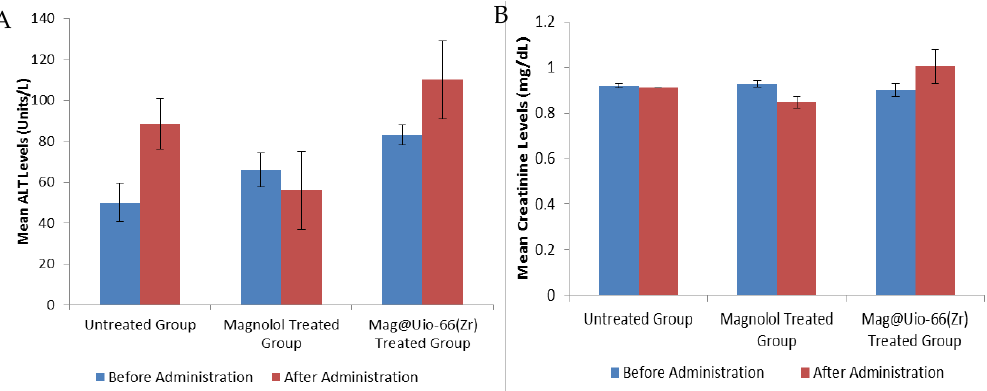
Figure 5. Serological parameter for acute oral toxicity. ( A ) mean ALT levels (units / L) for magnolol and mag@Uio-66(Zr) treated group, and ( B ) mean creatinine (mg / dL) levels for magnolol and mag@Uio-66(Zr) treated group. Blood extraction was done before and after administration of test compounds. n = 5. Data presented as mean ± S.E.M.